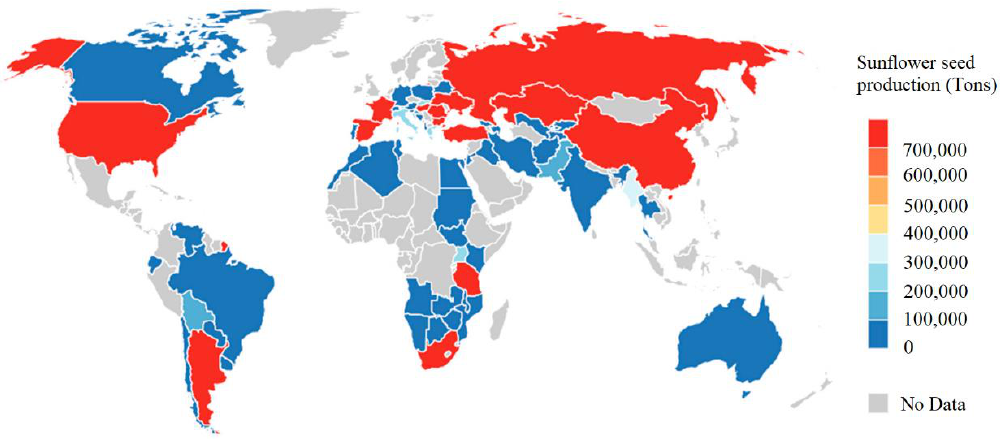
Figure 1. Distribution of sunflower seed production by country in the world .